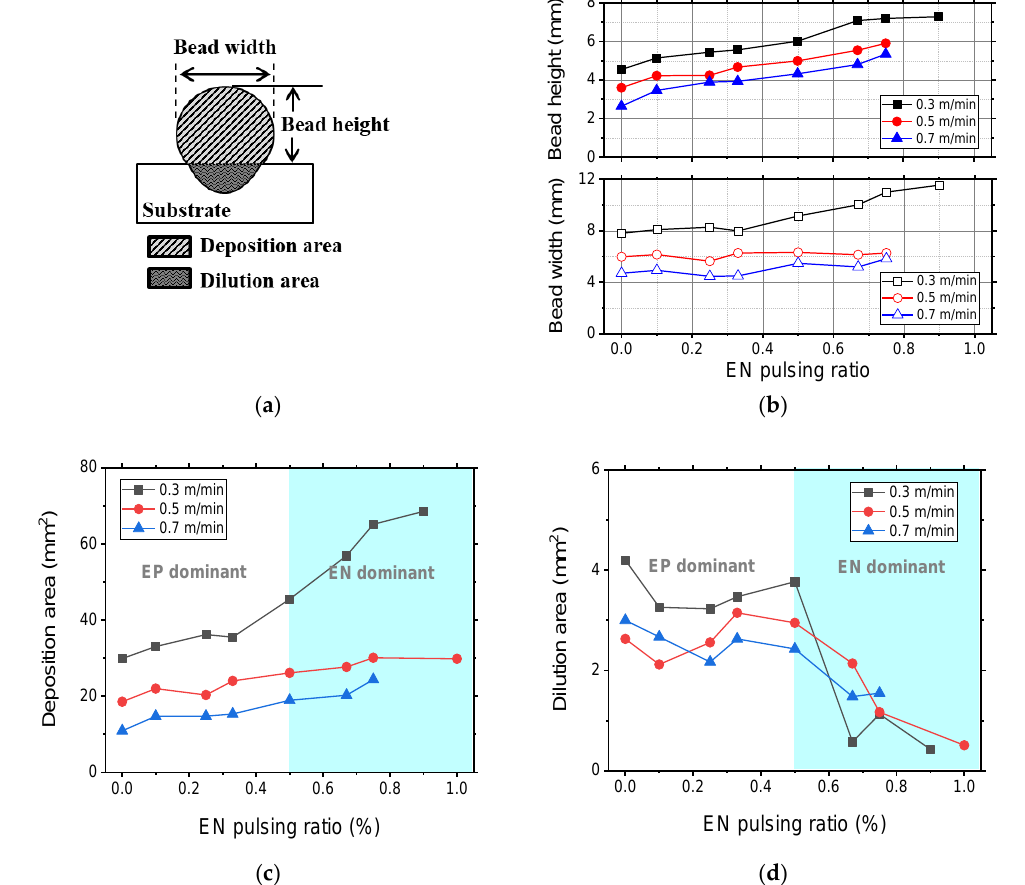
Figure 11. ( a ) Definition of geometrical factors that were analyzed according to the EN pulsing ratio; ( b ) bead height and width results; ( c ) deposition area results; and ( d ) dilution area results. These results were obtained for specimens that were measured under the three-repetition condition.